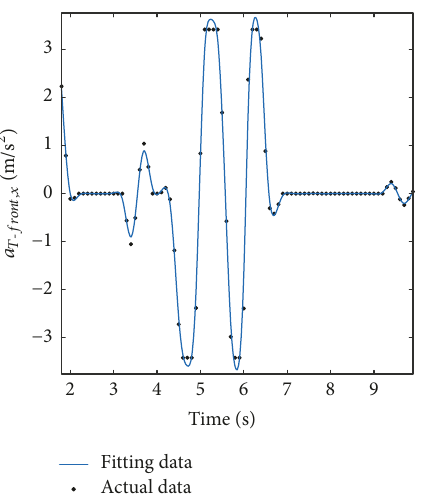
Figure 18: Acceleration curve of P-front in the positive direction of X-axis with time.